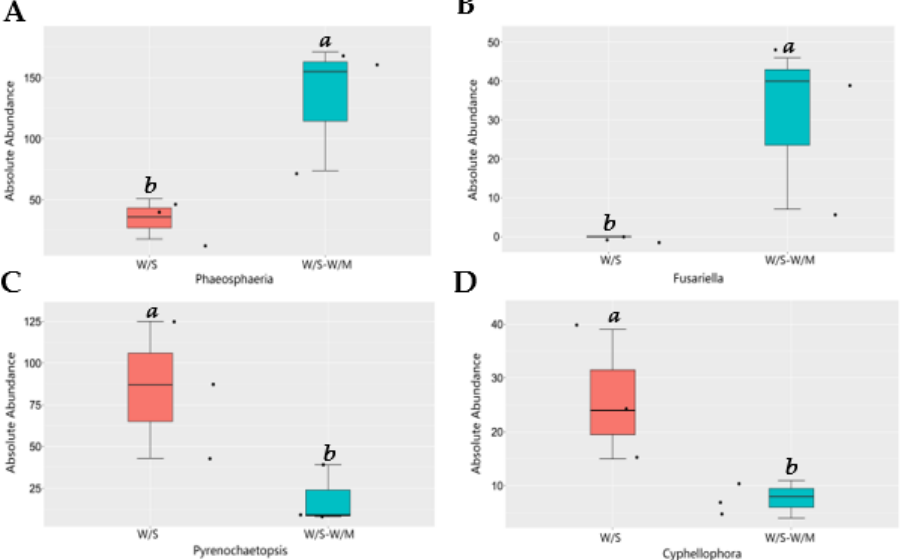
Figure 6. Relative abundance of potentially pathogenic fungi in two cropping systems. Different letters above columns signified statistically significant difference ( p < 0.05) according to MetaStat analysis. The dots represent three replicates for each treatment. W/S, continuous wheat/soybean cropping system; W/S-W/M, wheat/soybean-wheat/maize rotation system. ( A )- Phaeosphaeria ; ( B )- Fusariella ; ( C )- Pyrenochaetopsis ; ( D )- Cyphellophora